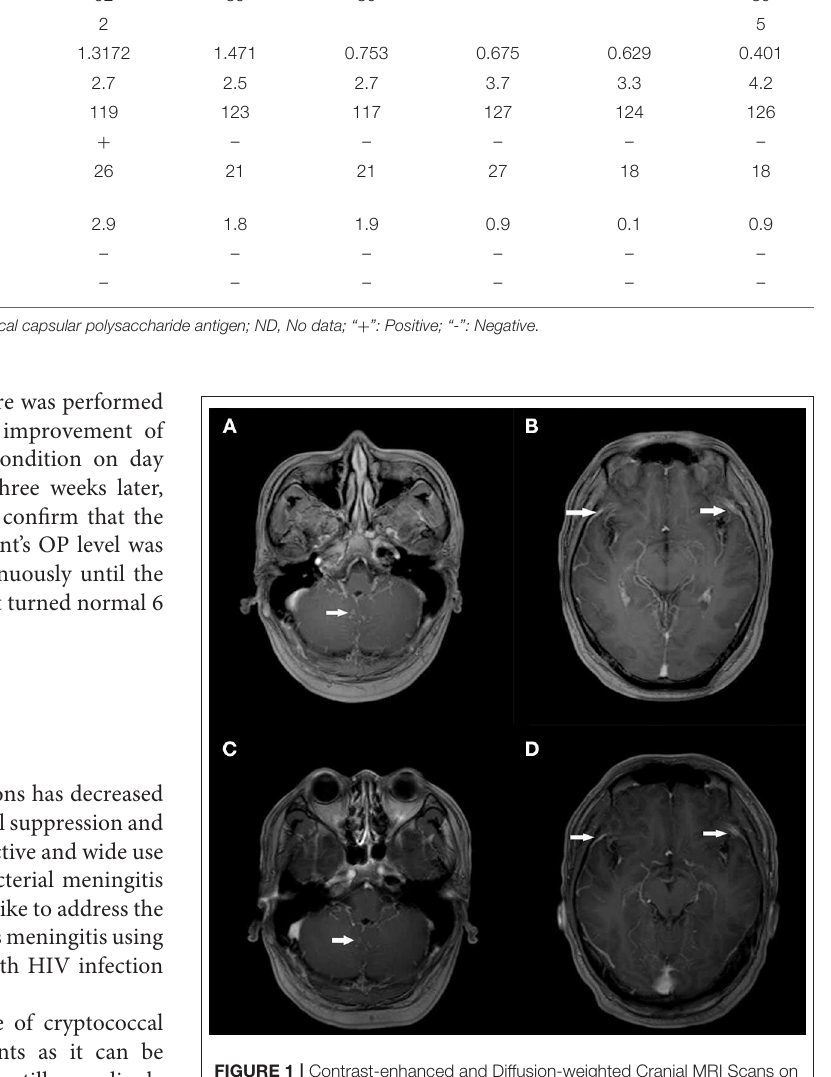
FIGURE 1 | Contrast-enhanced and Diffusion-weighted Cranial MRI Scans on Day 3 of Admission and after 6 Months. On the third day of